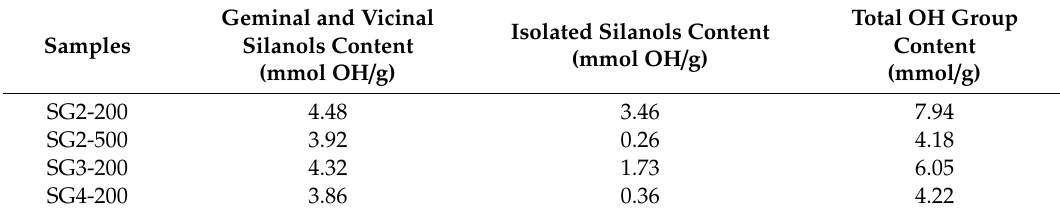
Figure 6. Typical TGA curves of porous silica glass for determining the amounts of silanol groups. Table 4. The concentration of silanol group on the prepared silica glass using